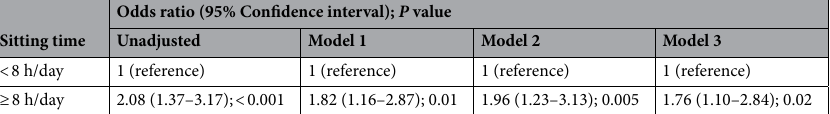
Table 4. Multivariate analysis of relationships of low tertiles with NID and sitting time on a non-working day. Model 1; adjusted for age, gender, body mass index, hypertension, dyslipidemia, diabetes mellitus, current smoking. Model 2; adjusted for age, gender, body mass index, hypertension, dyslipidemia, diabetes mellitus, current smoking, past CVD. Model 3; adjusted for age, gender, body mass index, hypertension, dyslipidemia, diabetes mellitus, current smoking, past CVD, exercise habit. NID indicates nitroglycerine-induced vasodilation; OR, odds ratio; CI, confidence interval. Low tertile of NID indicates less than 8.5%.